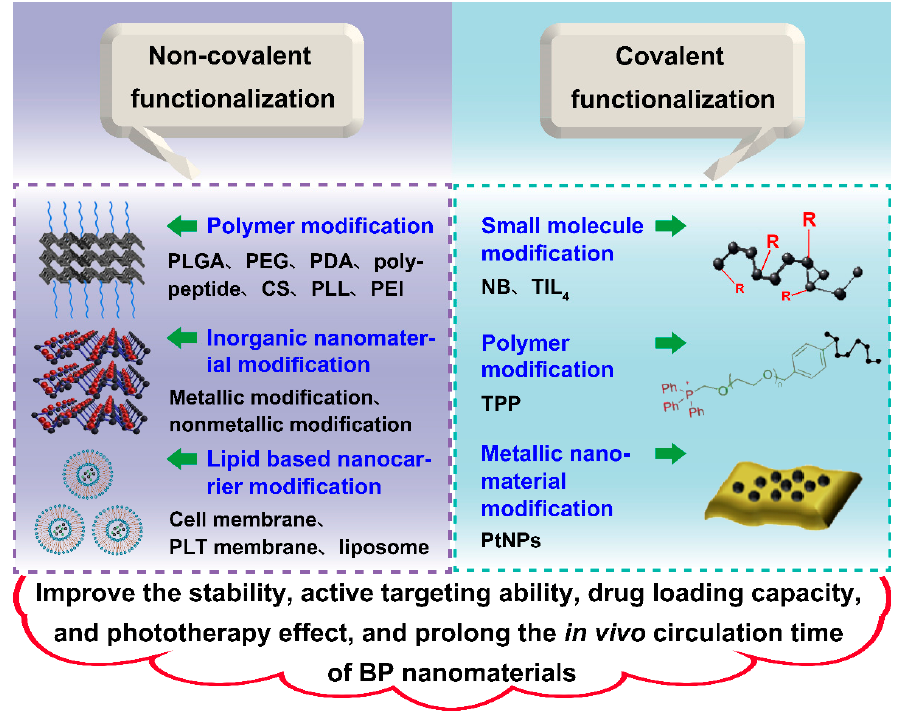
Figure 4. Schematic illustration of the surface modification of BP nanomaterials. BP nanomaterials